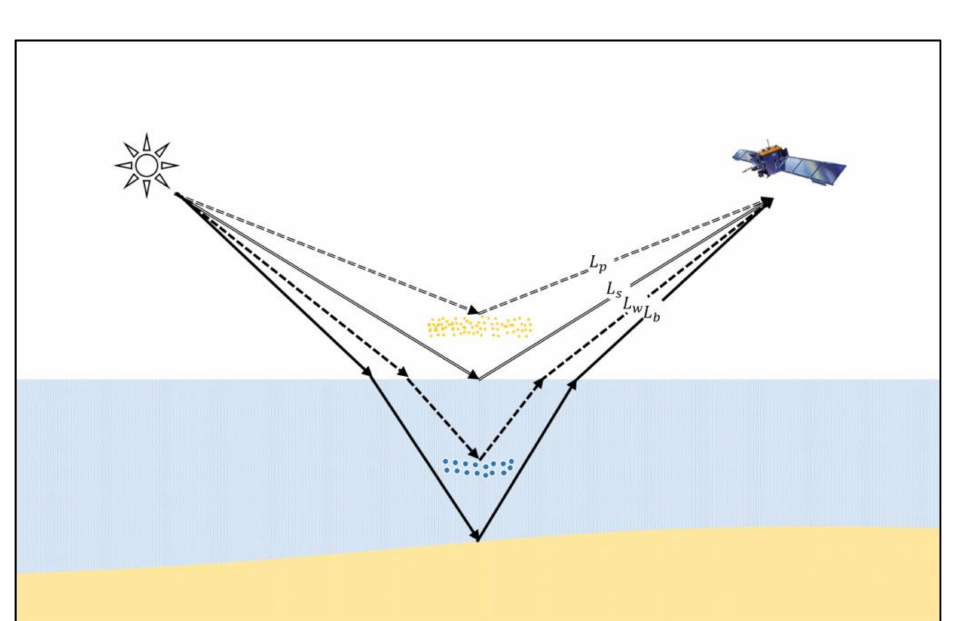
Figure 4. Imaging principle of underwater topography in the shallow or clear waters. The signal received by the sensor in this figure contains 4 parts: L p (the light scattering information of atmosphere), L s (the reflection information of sea surface), L w (the light scattering information of waterbody) and L b (the reflection information of